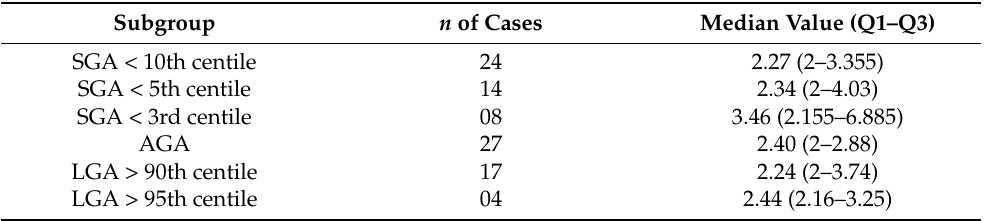
Table 4. Results of logistic regression analysis for the prediction of fetus status from the study parameters. ref: reference.